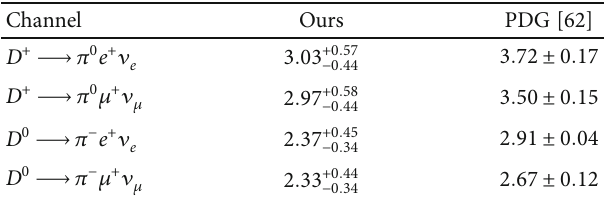
ℓ = e , μ Þ decays ℓ ð = 0 : 987